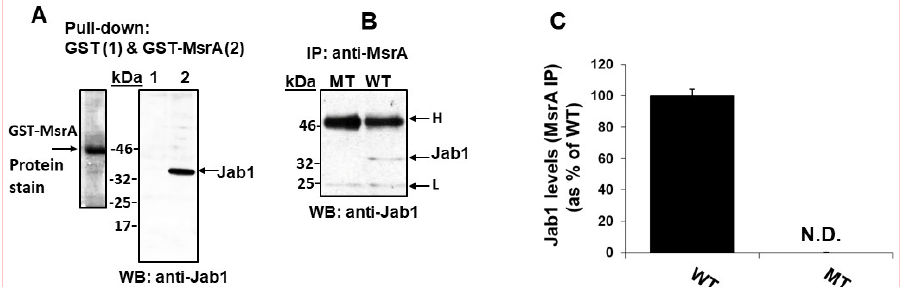
Figure 2. Interaction between MsrA and Jab1 in mouse brain extracts. ( A ) Pull-down experiments in which recombinant glutathione- S -transferase-MsrA (GST-MsrA) fused protein is used as a “bait” for binding of brain proteins. ( B) Immunoprecipitation (IP) experiments using mouse brain extracts and anti-MsrA antibody (IP antibody), followed by Western blot analysis using mouse anti-Jab1 primary antibody. C. Quantification of the Jab1 band detected by Western blot analysis in Panel B, by using the NIH Image-J program. N.D, not detected; kDa, molecular mass markers in kilo-Dalton units; WT, wild-type mouse; MT, MsrA KO mouse; L, light chain of mouse immunoglobulin detected in the extract; H, heavy chain of mouse immunoglobulin detected in the extract. Protein stain, Coomassie blue for protein staining. This experiment was repeated at least 3 times and one set of data is represented in this figure.